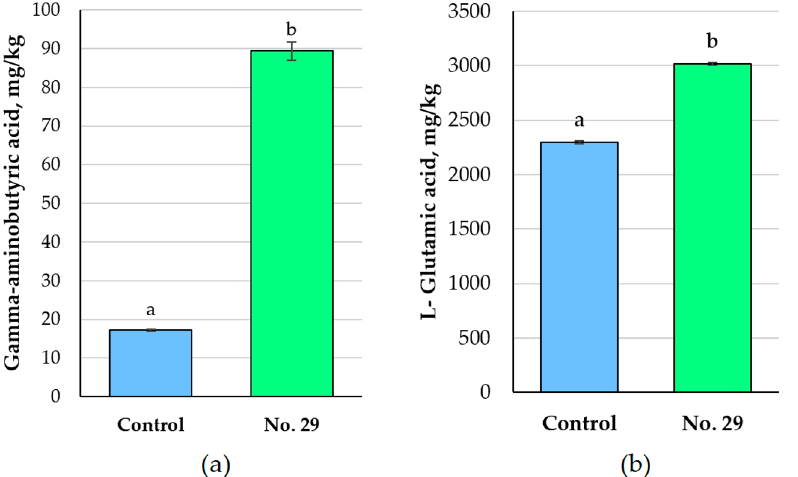
Figure 3. Concentrations of gamma-aminobutyric acid (GABA) ( a ) and L-Glutamic acid (L-Glu) ( b ) in the Spirulina samples (Control—Spirulina powder and water mixture, 1:2 w / w ; No. 29—Spirulina samples fermented with Pediococcus acidilactici, strain No. 29, for 24 h. Data are represented as means (n = 6) ± standard error. a–b mean values denoted with different letters indicate significantly different values between the samples ( p ≤ 0.05)).